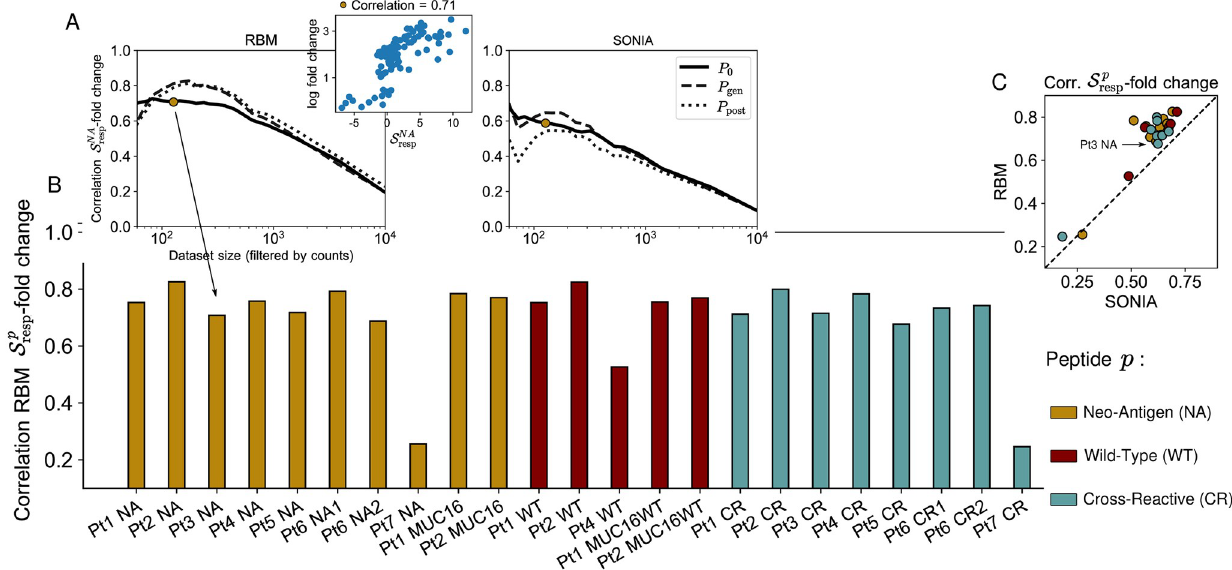
Fig 3. Model scores of T-cell clonal expansion. A: The RBM calculated response scores S p for each TRB clone in each antigen-stimulation condition p . resp The correlation between the S p and clone fold change is poor when considering all clones, as low-count clones are a source of noise. A significant resp correlation is recovered by progressively filtering out the low-abundance sequences from the testing set, shown on the example of stimulation by p = NA of Pt3 PBMC. For both RBM and SONIA (shown on the right), the correlation is robust to the choice of different background distributions: P 0 (the probability learned on the same patient’s dataset at day 0), P gen (the probability of generating a given CDR3, described by OLGA [21]) and P post (the post- thymic selection CDR3 distribution, sampled here from a default human TRB model available in SONIA [15]). The small differences between the 3 curves are mainly due to sampling, see also Materials and methods. B: The correlation coefficient between the RBM S p and clone fold change for each antigen- resp stimulation experiment p (color-coded by antigen) when retaining the 125 most abundant clones (the golden dot in panel A). Data from [16] correspond to p = NA, CR, WT, MUC16, MUC16WT (Pt1, Pt2), p = NA, CR (Pt3, Pt5, Pt7), p = NA, CR, WT (Pt4), P = NA1, CR1, NA2, CR2 (Pt6), see also Table 1. C: Scatter plot comparing S p from the RBM and resp